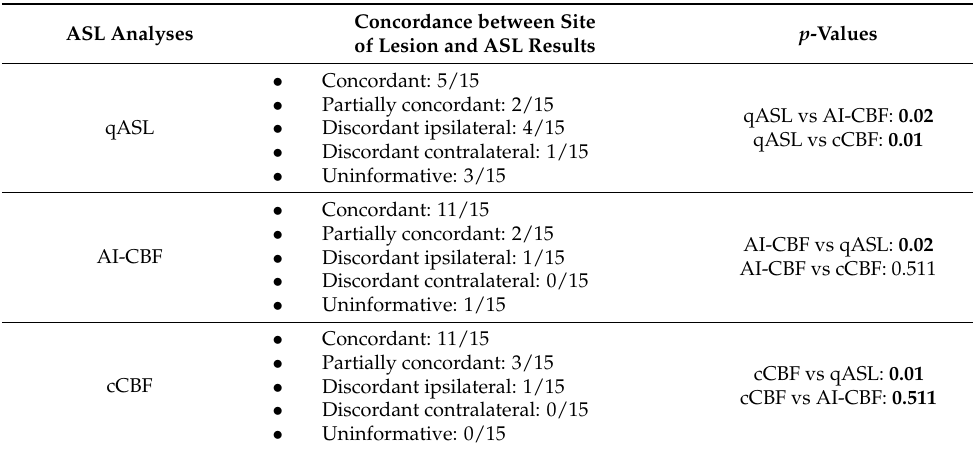
Figure 1. Two cases of pediatric patients with focal epilepsy and frontal left EEG abnormalities. In the first patient ( a – d ), axial FLAIR image ( a ) shows left frontal focal cortical dysplasia (white arrow), while axial ASL-CBF map ( b ) identified a slight reduction of CBF in the left frontal region. Quantitative voxel-based analysis of the Asymmetry Index ( c ) confirmed a region of asymmetry of CBF in the frontal lobes with reduced perfusion in the left side. Quantitative voxel-base analysis of cCBF ( d ) identified a region of significant reduction of CBF in the left frontal lobe compared with age-matched healthy controls. In the second patient ( e – h ), axial FLAIR image ( e ) and axial ASL-CBF map ( f ) did not show any structural lesion or perfusion abnormalities at visual qualitative analysis. In contrast, quantitative voxel-based analysis of the Asymmetry Index ( g ) showed a region of asymmetry of CBF in frontal lobes with reduced perfusion in the left side. Quantitative voxel-base analysis of cCBF ( h ) identified a region of significant reduction of CBF in the left frontal lobe compared with age-matched healthy controls. Note: Color bars in ( b , f ) indicate CBF values mL/min/100 g. Color bars in ( c , g ) indicate values of the Asymmetry index with red-to-yellow indicating positive values and blue-to-lightblue indicating negative values. Colorbars in ( d , h ) indicate z-score values of the CBF comparison between the single subject and healthy controls.